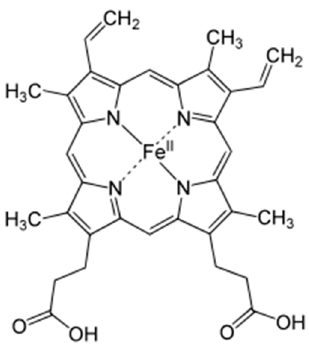
Figure 5. Iron structure.